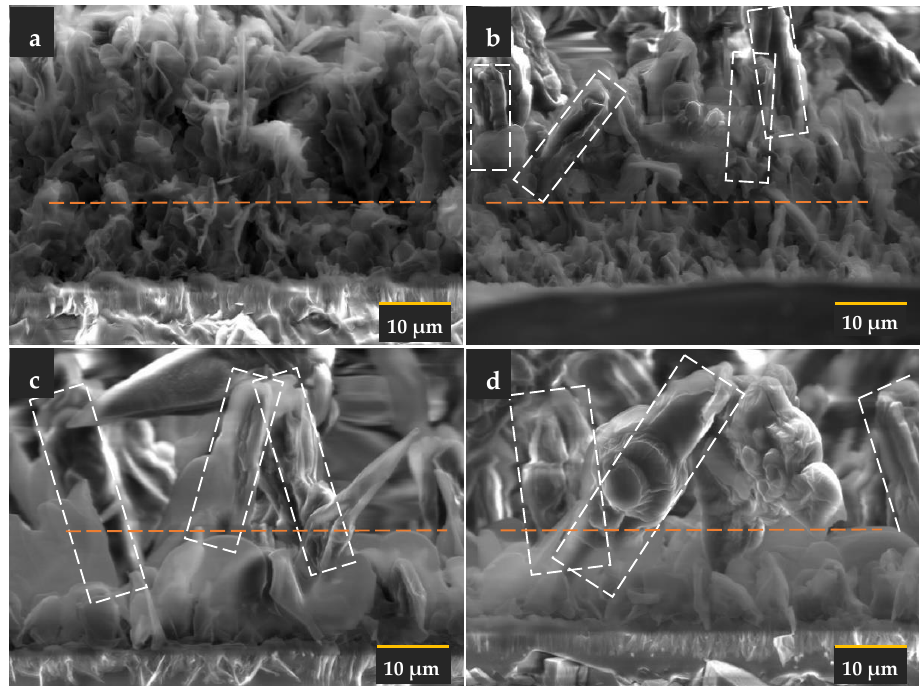
Figure 3. Cross-sectional electron micro-images of the stearic acid layer deposited at ( a ) 1 min, ( b ) 2 min, ( c ) 3 min, and ( d ) 4 min. The white rectangle identifies the pillar-like structure, while the orange line separates the distinguished upper and bottom microstructures.